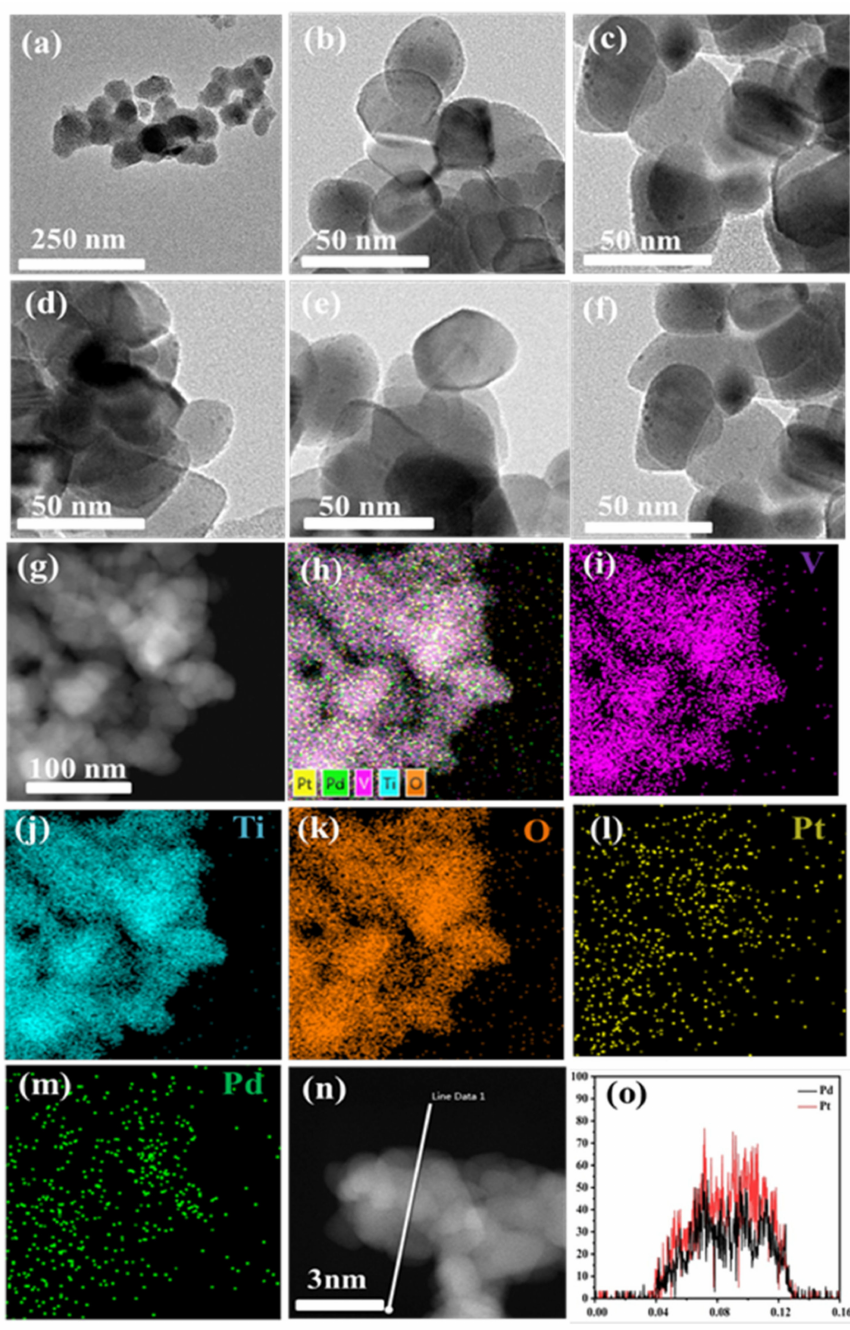
Figure 2. ( a – f ) TEM and ( g , n ) HAADF-STEM images, ( h – l ) elemental mappings, and ( o ) line-scan elemental analysis of ( a ) V 2 O 5 -TiO 2 , ( b ) 0.46PdPt 2.10 /V 2 O 5 -TiO 2 , ( c ) 0.41PdPt 0.85 /V 2 O 5 - TiO 2 , ( d ) 0.49PdPt 0.44 /V 2 O 5 -TiO 2 , ( e ) 0.47Pt/V 2 O 5 -TiO 2 , ( f ) 0.39Pd/V 2 O 5 -TiO 2 , and ( g – o ) 0.46PdPt 2.10 /V 2 O 5 -TiO 2